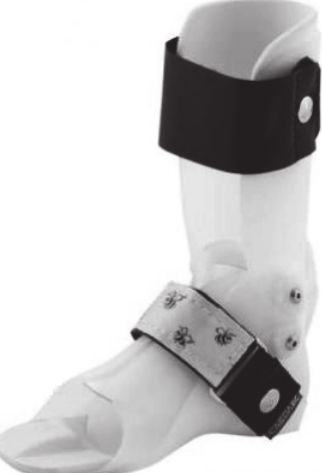
Figure 3: Dynamic ankle foot orthosis prescribed to the 12 year old patient to provide him with good support of the foot and ankle when